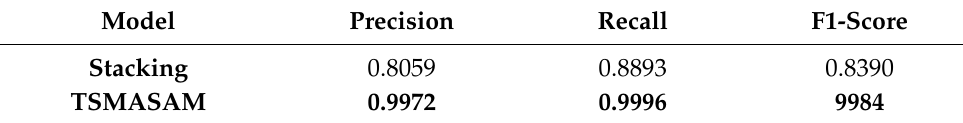
Table 3. The impact of the Sample Associative Learning on the